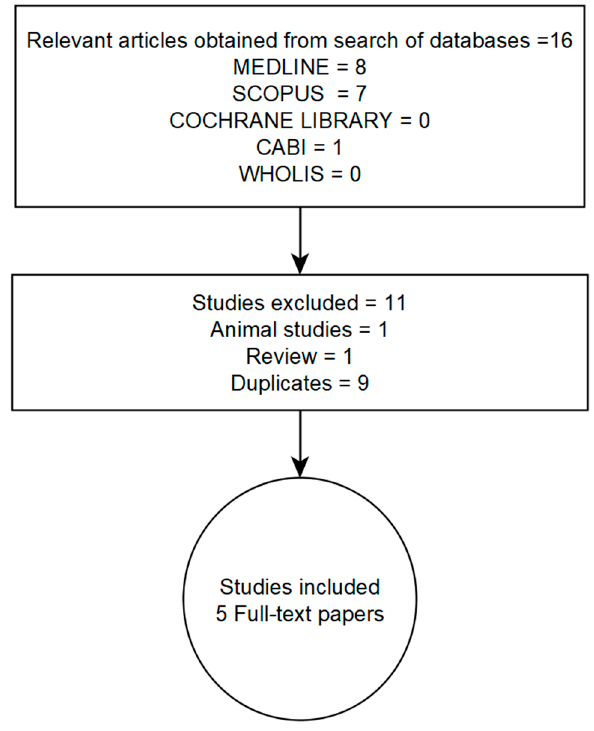
Figure 2. Flowchart showing databases searched and the selection and inclusion of the studies in this review. * CABI = Center for Agriculture and Bioscience International, WHOLIS = World Health Organization Library Information System (WHOLIS).